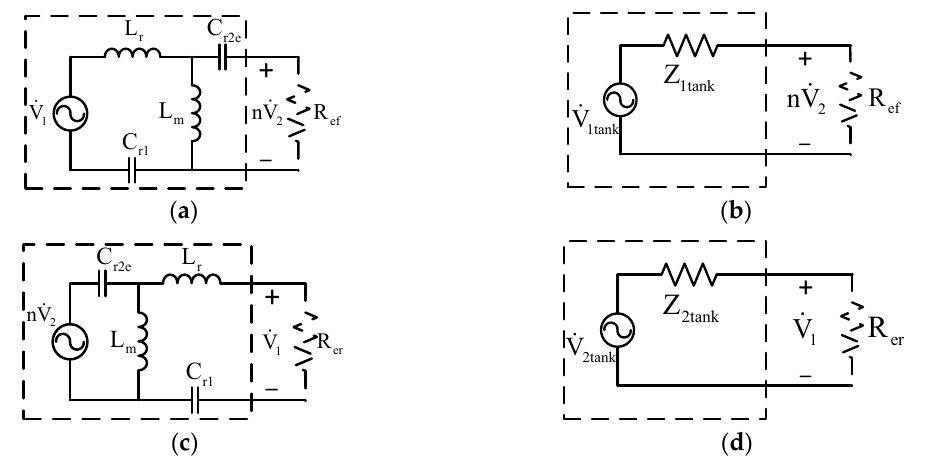
Figure 4. Equivalent circuits of the forward mode and the reverse mode. ( a ) FHA circuit of the forward mode; ( b ) Thevenin equivalent circuit of ( a ); ( c ) FHA circuit of the reverse mode; ( d ) Thevenin equivalent circuit of ( c ).